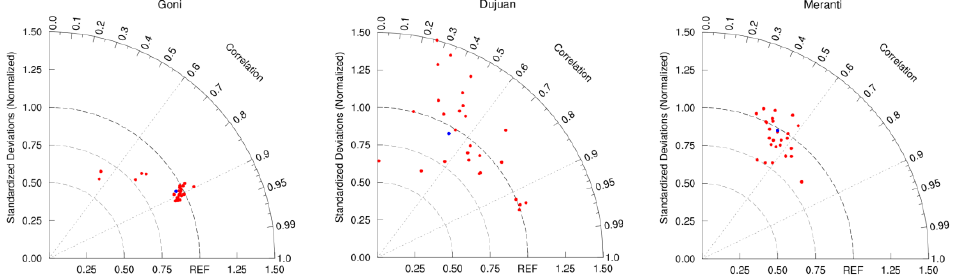
Figure 6. Taylor diagrams of the wind direction for the three typhoon events and 27 experiments. Red dots stand for experiments, and blue dots stand for ensemble prediction.